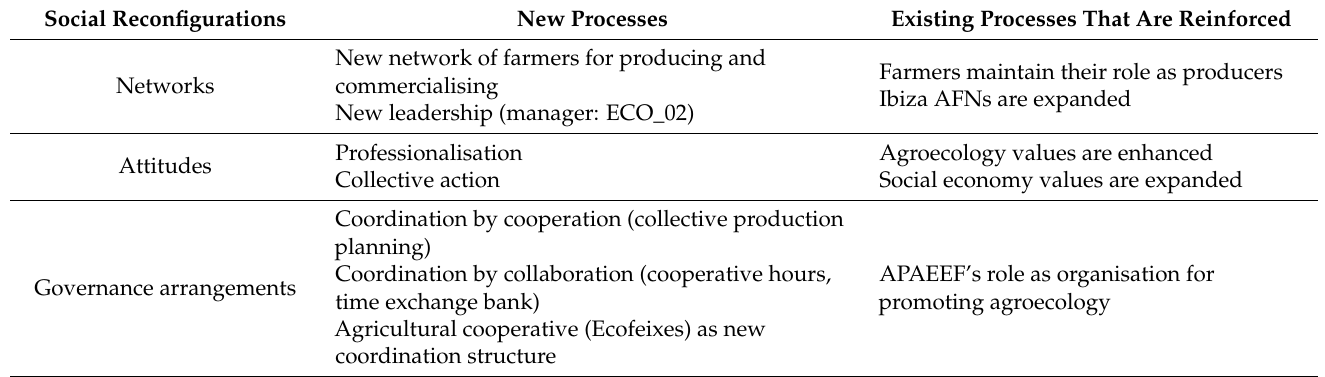
Table 2. Reconfiguration of social relations in Ecofeixes. Own